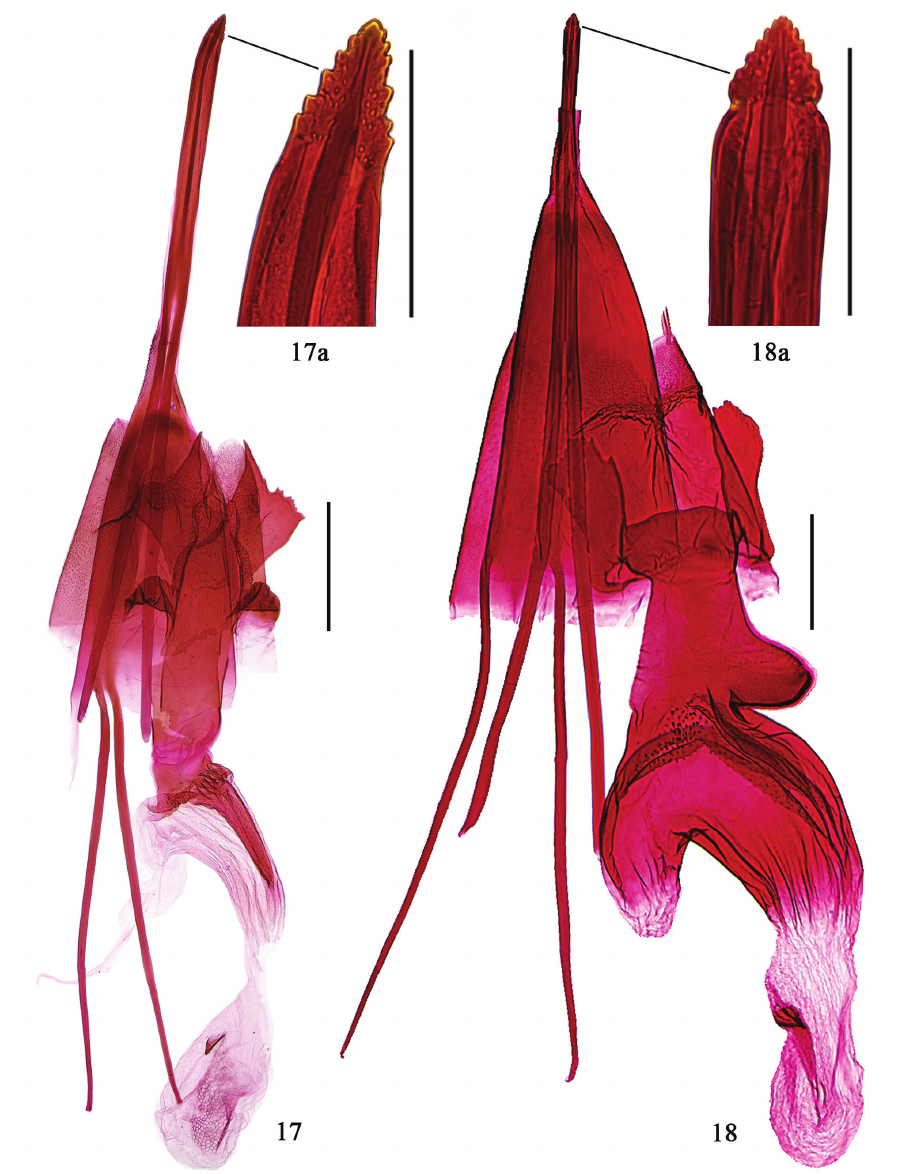
Figures 17–18. Female genitalia of Epicephala spp. 17 E. camurella sp. n., paratype, genitalia slide No. WZB14253 18 E. angustisaccula sp. n., paratype, genitalia slide No. WZB14412. Scale bar: 0.5 mm ( 17, 18) ; 0.1 mm ( 17a, 18a Etymology. The specific name is derived from the Latin angustus (narrow) and sacculus , in reference to the distally narrowed sacculus in the male genitalia.